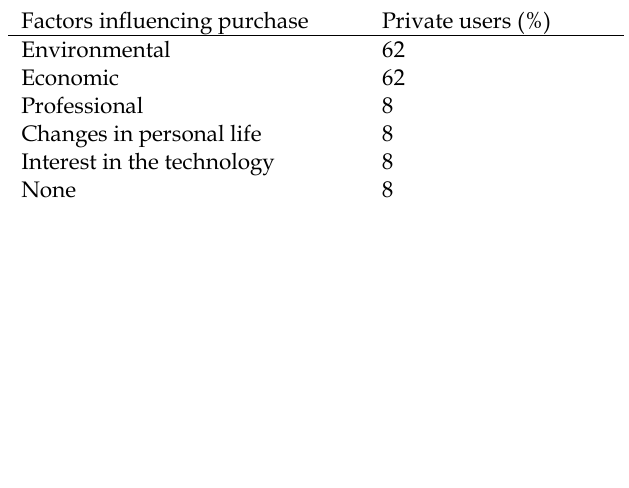
Table 1 Factors influencing the EV purchase decision for private users (percentage of